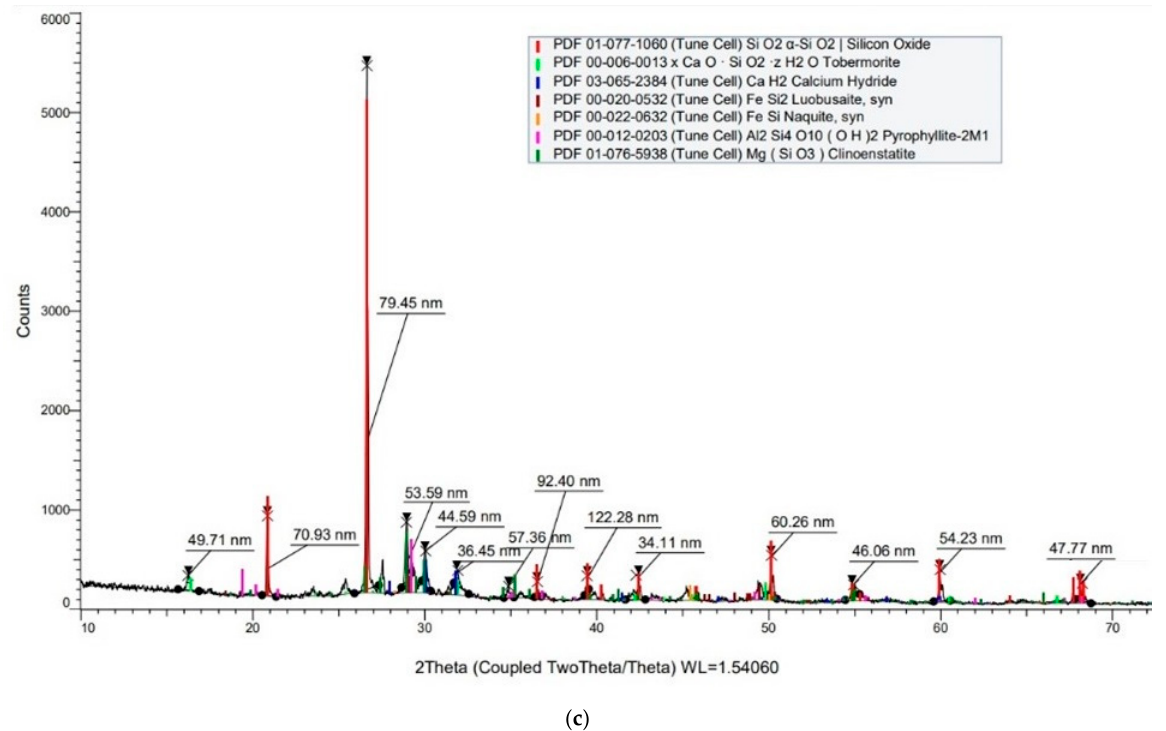
Figure 8. XRD patterns of AAC-R30 ( a ), AAC-R50 ( b ), and traditional AAC ( c ). Figure 9a–c depict the morphology of the AAC-R30, AAC-R50, and traditional AAC surfaces to show the microstructure of each composition by FESEM examination. The sur- face of the AAC-R30 blocks showed finer pores with more thick pores than the AAC-R50 block, which contains more large pores. In contrast, AAC-R30 also had a smoother surface with significantly fewer pores than traditional AAC.